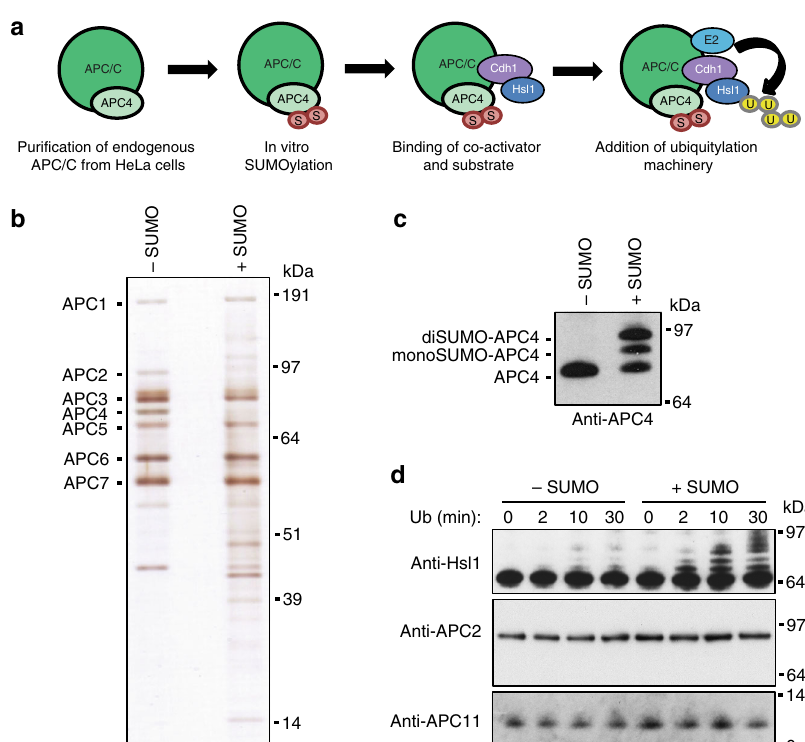
Fig. 5 SUMOylation of the endogenous APC/C enhances its ubiquitylation ef fi ciency toward the model substrate Hsl1 in vitro. a Schematic overview on the experimental approach: Endogenous APC/C was puri fi ed from HeLa cells making use of beads coupled with anti-CDC27 antibody. The puri fi ed complex was SUMOylated in vitro. As a negative control, half of the puri fi ed complex was incubated with the SUMOylation machinery leaving out the